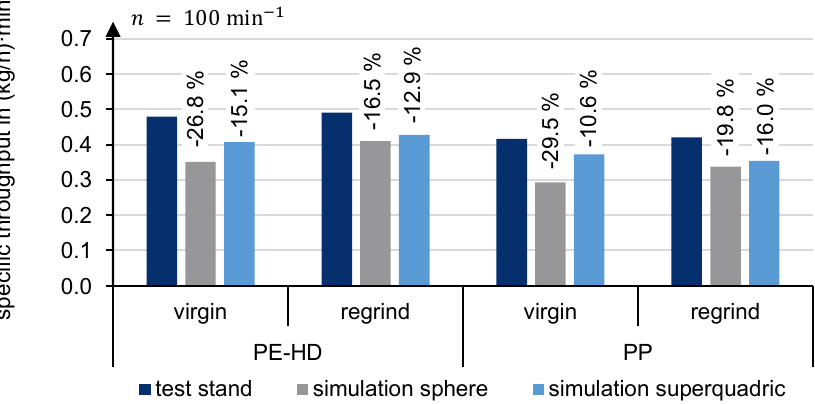
Figure 22. Mass throughput comparison between experiment and simulation.